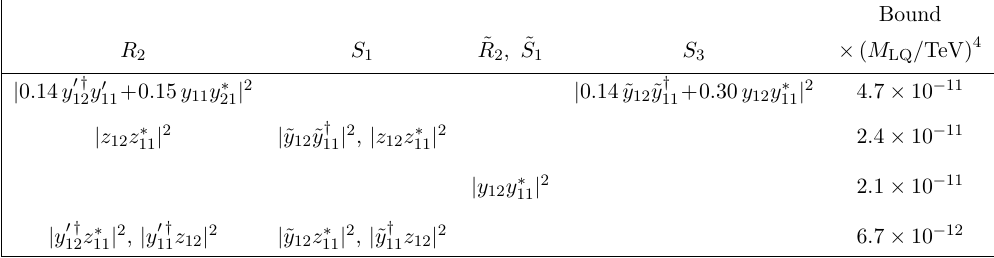
Table 7 . Bounds on leptoquark couplings from muon conversion to electron in gold